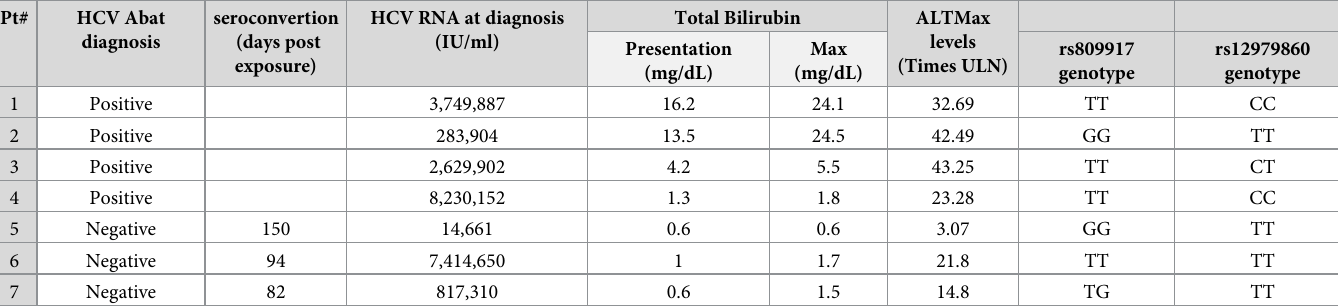
HCV while undergoing CT scans. Seven of the twelve patients infected in this outbreak were managed at our center (SMCZ) while five were managed at another center as recently reported [21]. Modeling of patient data (i.e., predicted source viral load) and features of the CT proce- dure that led to the outbreak (i.e., saline bottle volume range, volume of saline that each patient received and plausible range of HCV RNA titer to infectivity ratio) provided new insight into HCV transmission suggesting that very small amounts of contaminated blood (0.6–8.7 μ l) diluted in saline from a CHC patient with a viral load within the typical viral load range in noncirrhotic chronic HCV-infected patients [23] can lead to infection of 100% of recipients. Higher contaminating volumes might be necessary for individuals with lower viral load such as decompensated cirrhotic patients [24] and those who have secondary infections [25], as shown in Fig 3. Our probabilistic model (Eq 1) provides a more rigorous way to determine the minimum amount of HCV RNA needed to transmit infection compared to a previous estimate by Oper- skalski et al [26]. For HCV transmission via blood transfusion, Eq 1 can be simplified to P = 1-(1-q) n (termed modified model), where q parameter remains the RNA to infectivity ratio (same range 1:11 to 1:100 as in Eq 1 which is in agreement with the suggested range described by Operskalski et al) and n represents the total number of HCV RNA copies transfused to the